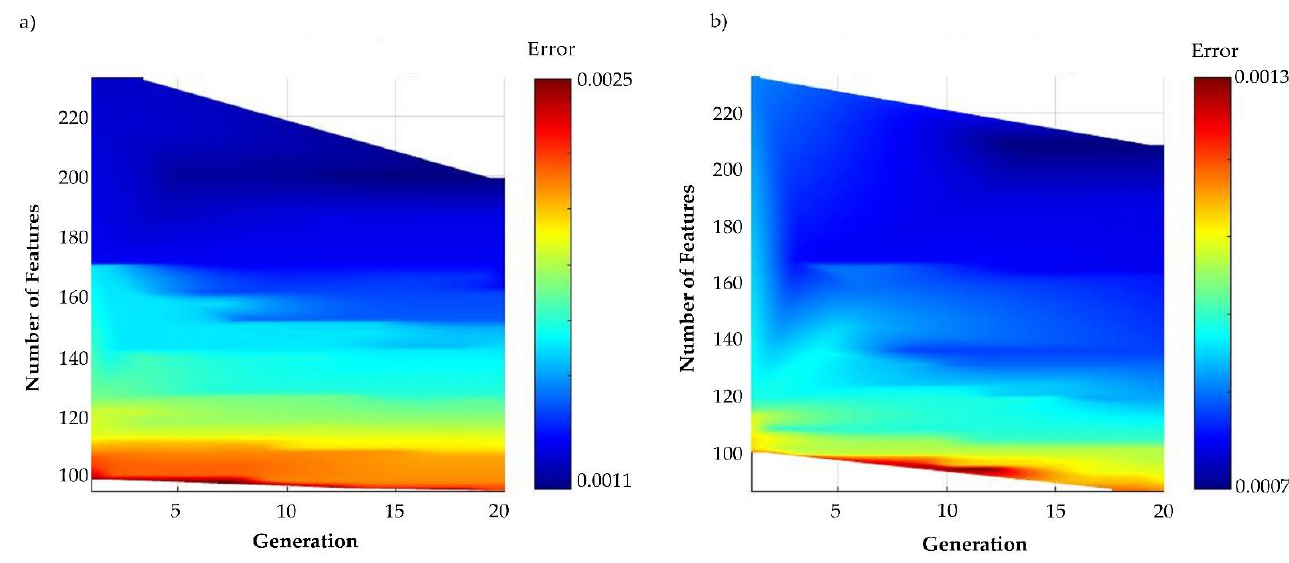
Figure 9. Bi-objective error landscape of SFSS algorithm during lithotype ( a ) and Au ( b ) estimation.